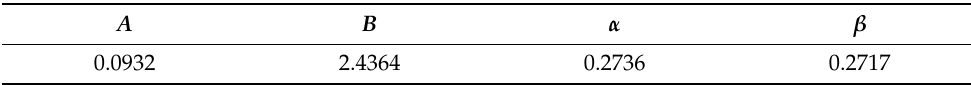
Table 8. Fitted values by empirical expression at 10